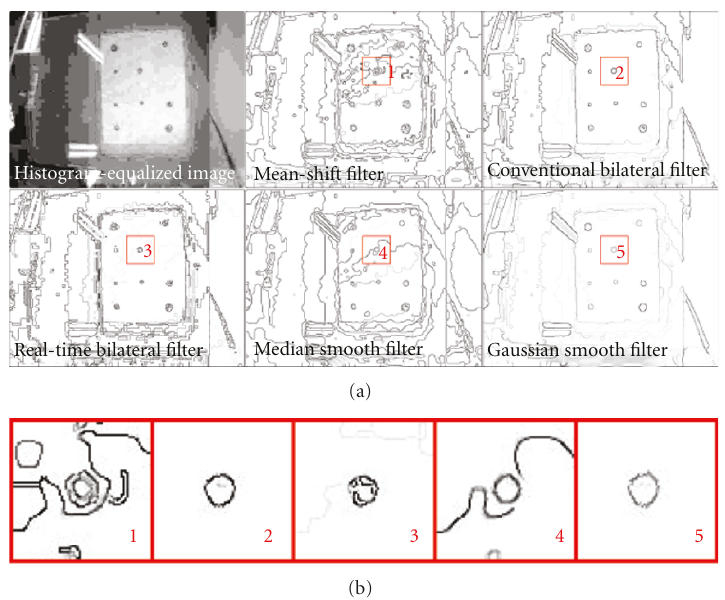
Figure 8: The scale maps of the multiscale Canny edge detection ( N = 4) using di ff erent simplification filters. Top left is the histogram- equalized image before the multiscale detection is